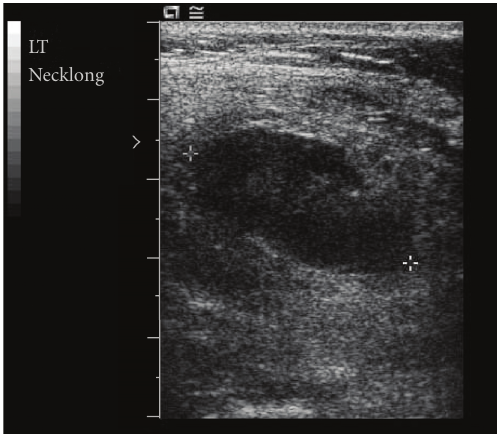
Figure 2: Ultrasonogram of the largest lymph node at the site of cervical swelling. The lymph node was a solid mass measuring 2 . 6 × 3 .